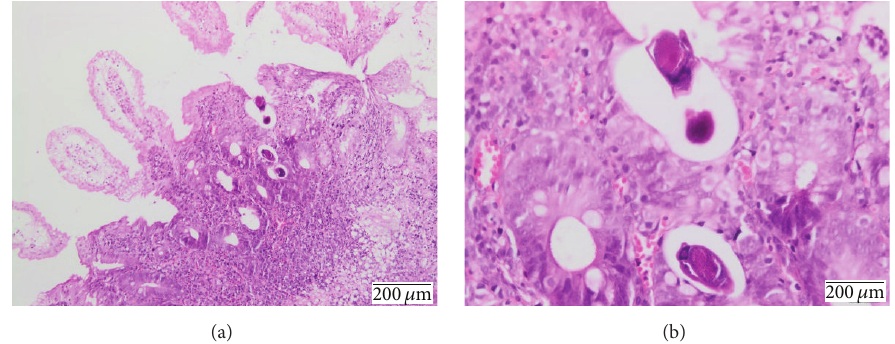
Figure 6: Duodenal biopsy showing preserved villi with dystrophic glands, multiple ulcerations, and eosinophilic infiltration. Parasitic larvae are also seen either superficial or encrusted into the mucosa compatible with strongyloidiasis.